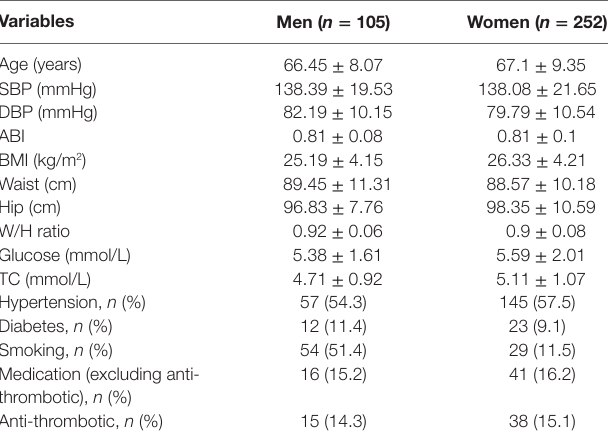
TaBle 3 | Characteristics of study participants who developed peripheral arterial disease at follow-up.